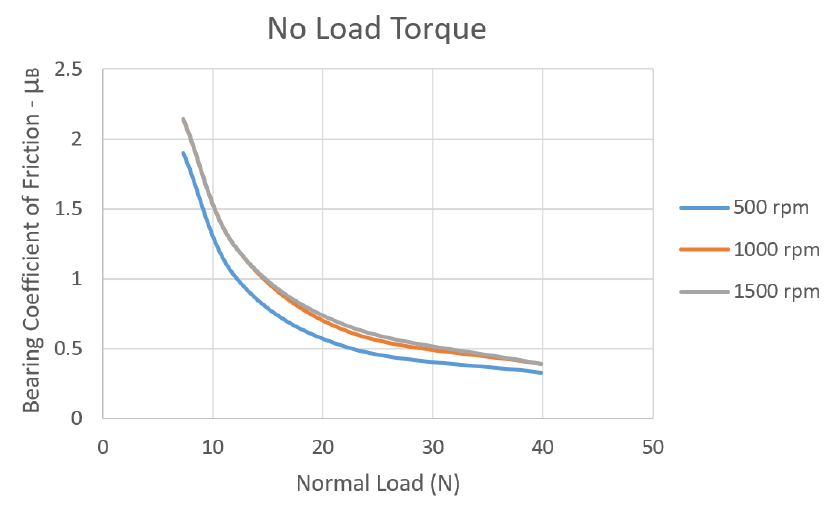
Figure 5. Results of no-load torque tests at 500, 1000 and 1500 rpm.